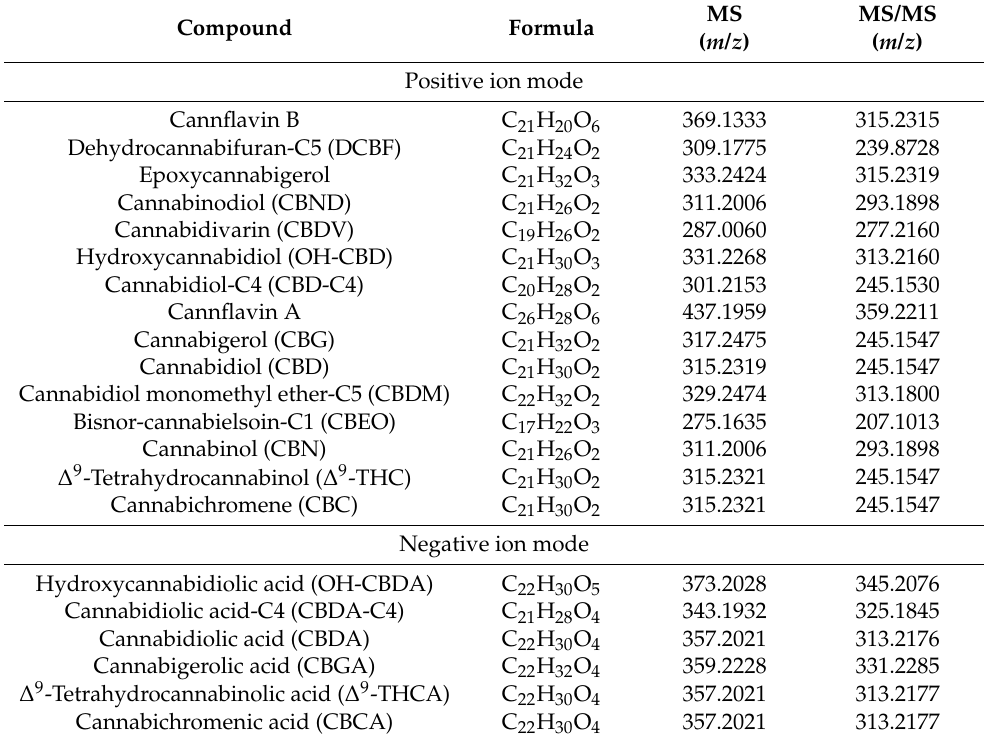
Table 1. Chemical formula, MS, and MS/MS data of the compounds identified in hemp oils both in the positive and negative ion mode by